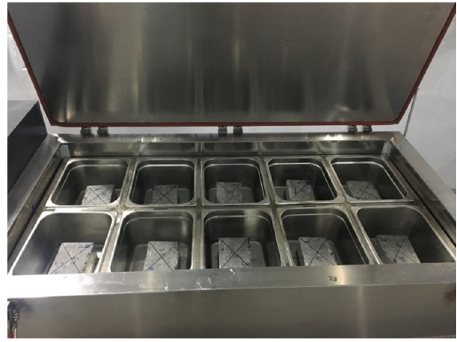
Figure 5: Instrument used for RCM test. Figure 6: Instrument used for frost resistance